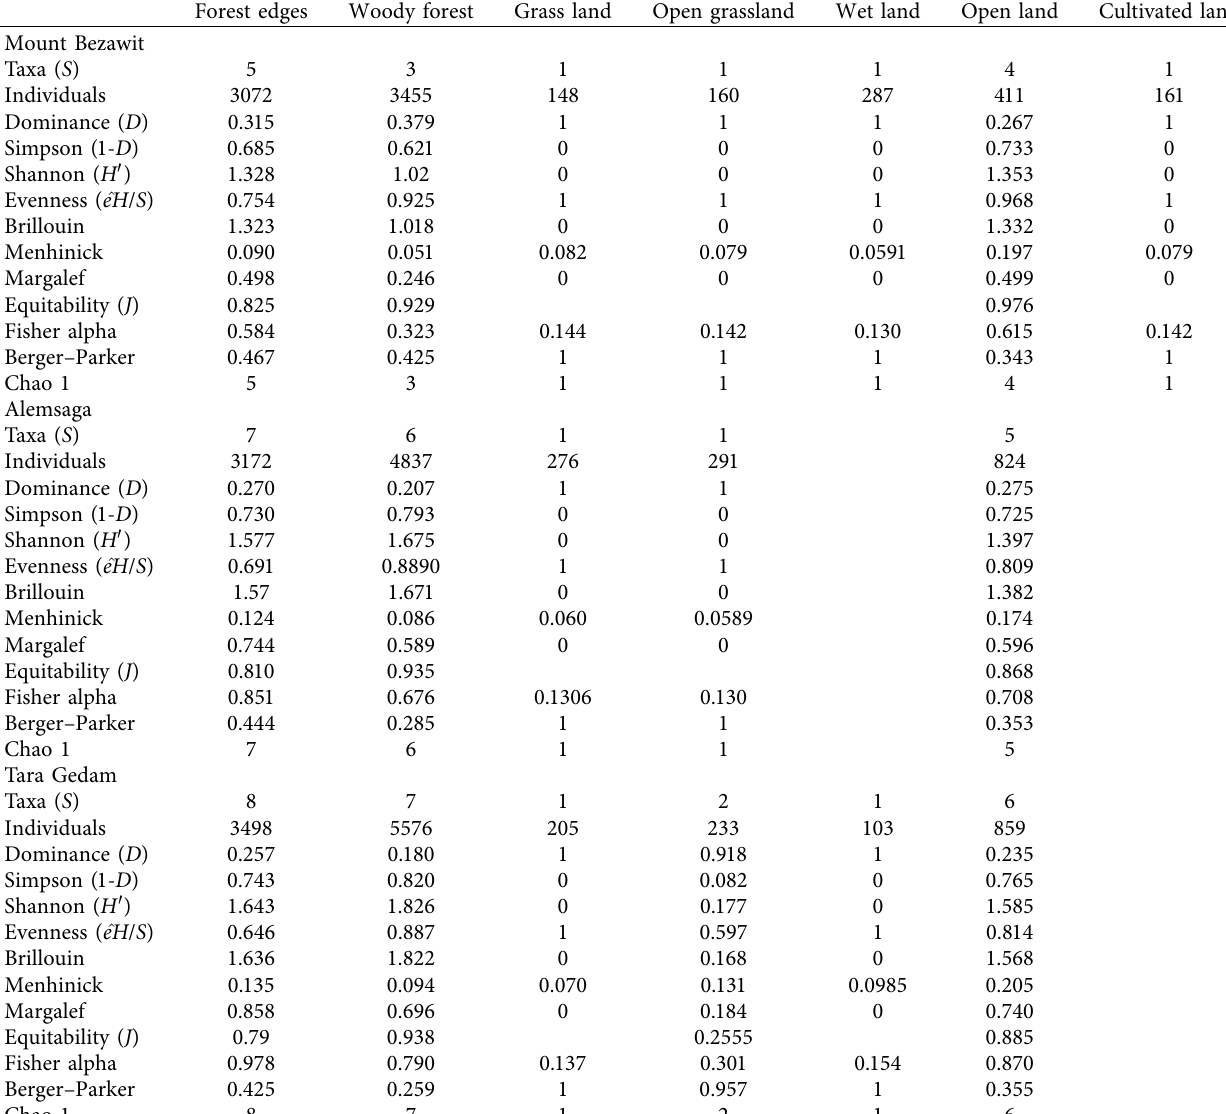
Table 5: Diversity indices for butterfly communities at different habitat